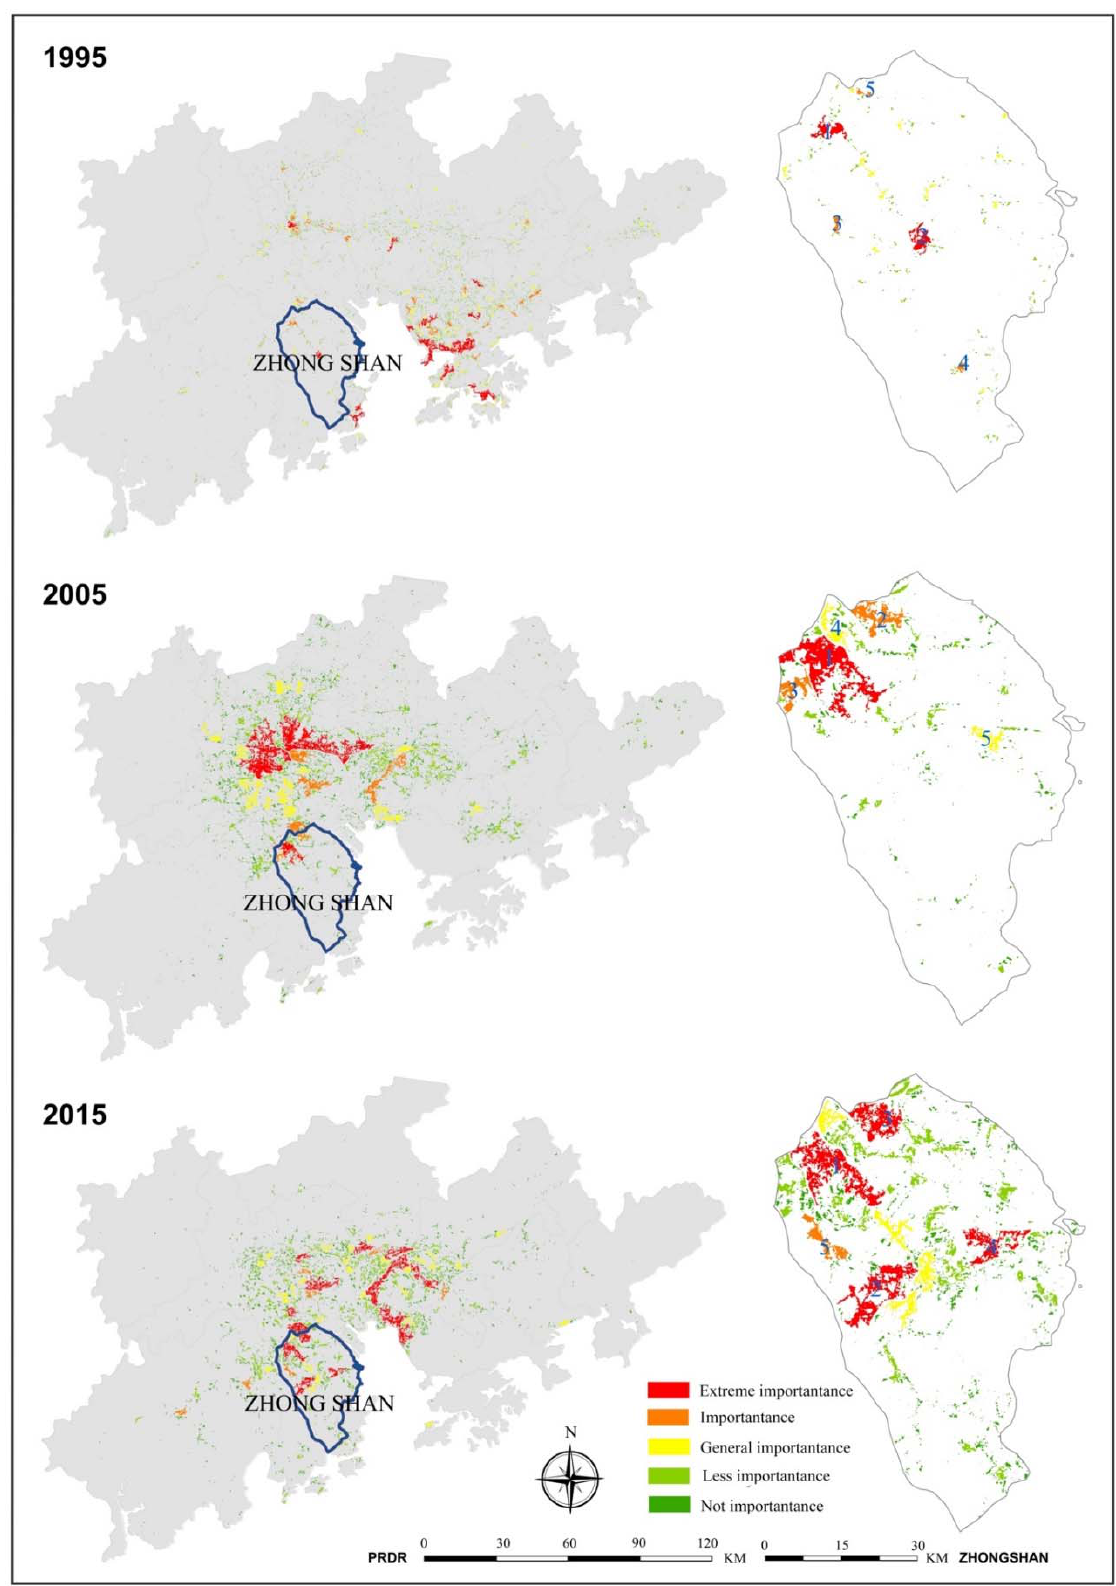
Figure 6. The results of core importance based on connectivity analysis from 1995 to 2015 in PRDR and specific Zhongshan City (detailed enlarged maps, please see the Supplementary Material).